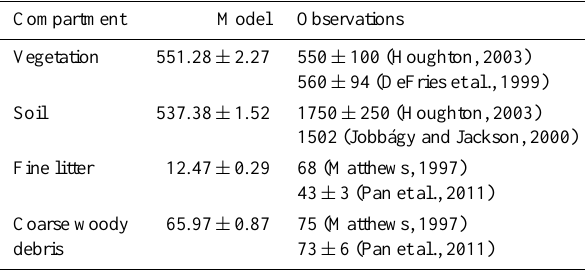
Table 3. Globally integrated annual mean vegetation, soil, fine litter, and woody debris carbon pools simulated by the land carbon cycle in NorESM over the 1982–2005 periods together with observational estimates. Units are in [PgC].